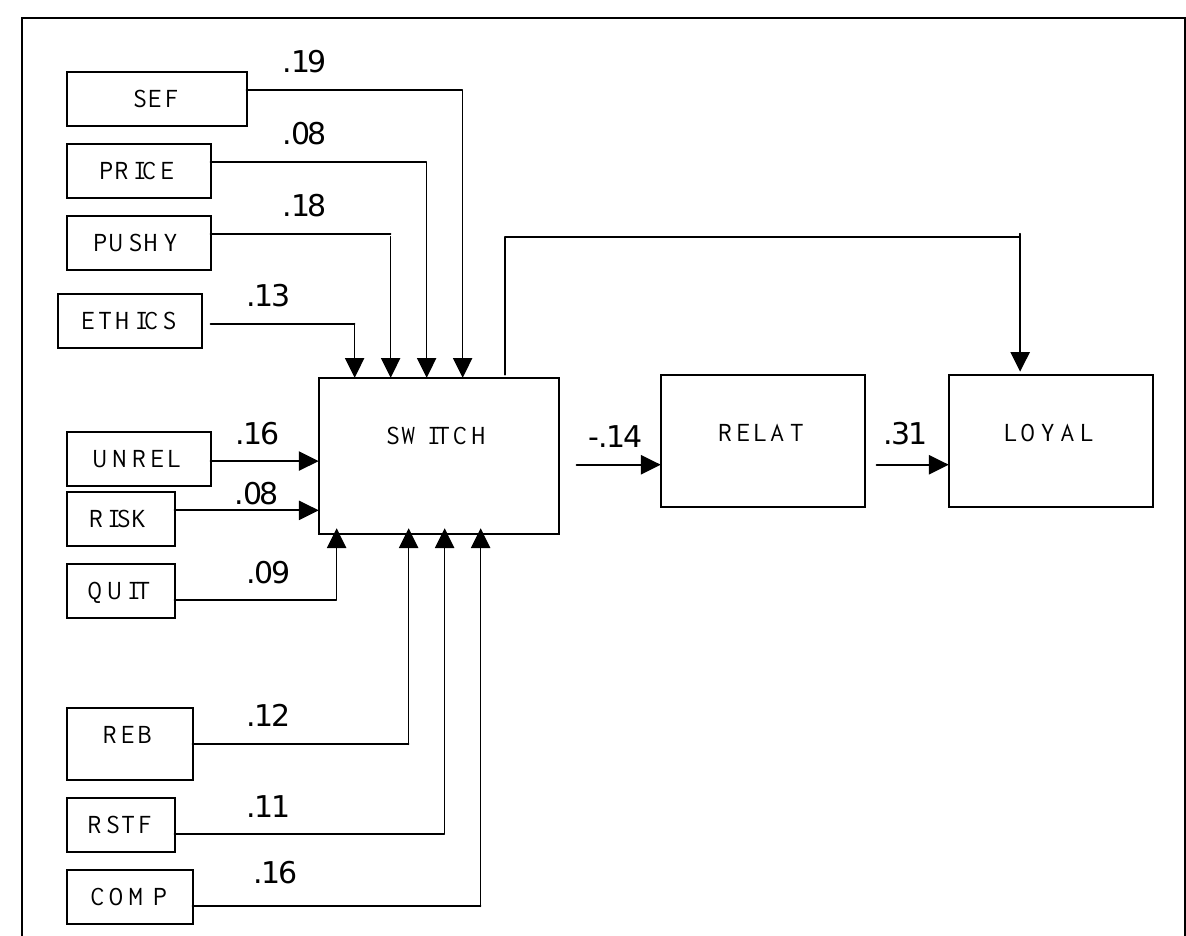
Revised switching behaviour